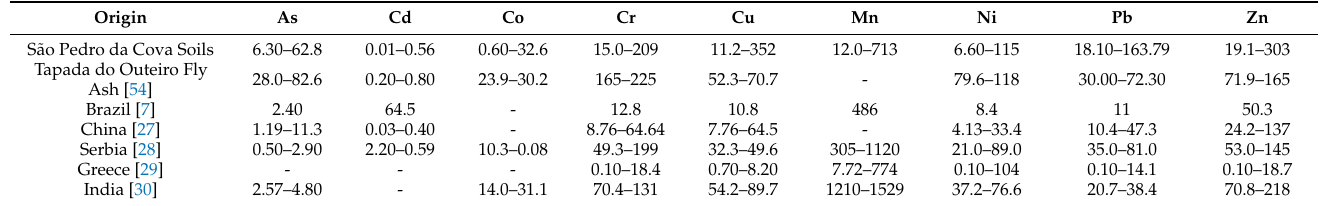
Table 3. PTEs concentrations in soils surrounding the waste pile of S ã o Pedro da Cova waste mine affected by active coal fire, in fly ash from Douro Coalfield combustion in Tapada do Outeiro thermal power production and comparison with the soils surrounding coal power production centrals worldwide (mg/kg).